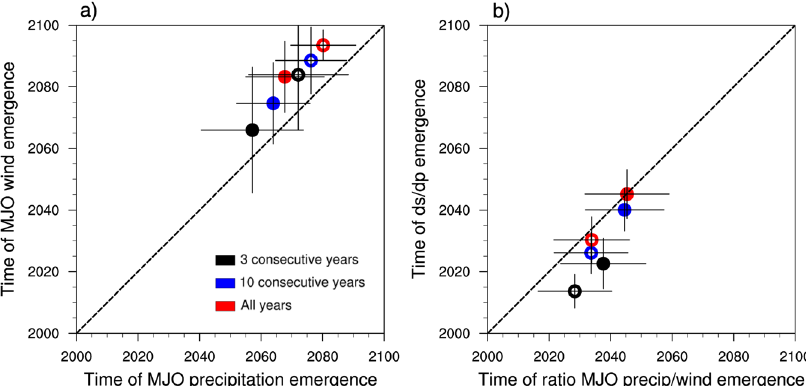
Fig. 4 Differences in timing of emergence of MJO amplitude. Scatterplot of the projected timing of a MJO precipitation amplitude ( x axis) versus MJO wind amplitude ( y axis) and b ratio between MJO precipitation to MJO wind amplitude ( x axis) versus the vertical DSE gradient (ds/dp, y axis). Data are averaged over the two boxes in Fig. 3a including the Indo-Paci fi c warm pool (open/hollow dot, 15°S-Eq., 60°E-180°) and central-eastern Paci fi c (solid dot, 15°S-Eq., 90°W-160°W) for three different consecutive year thresholds to de fi ned emergence. The bars represent the standard deviation calculated across all ensemble members from CESM2-LE. The dotted line shows a 1:1